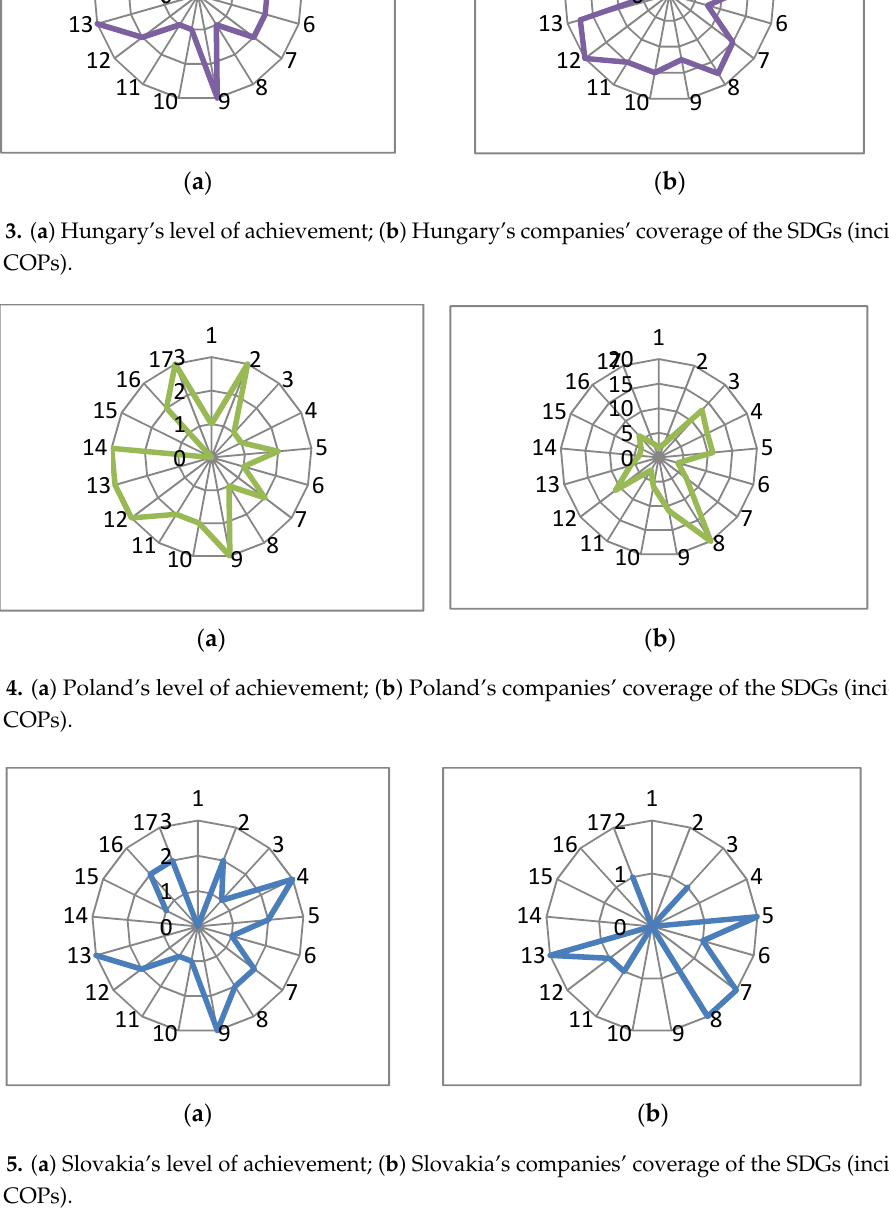
Figure 5. ( a ) Slovakia’s level of achievement; ( b ) Slovakia’s companies’ coverage of the SDGs (incident rate in COPs).